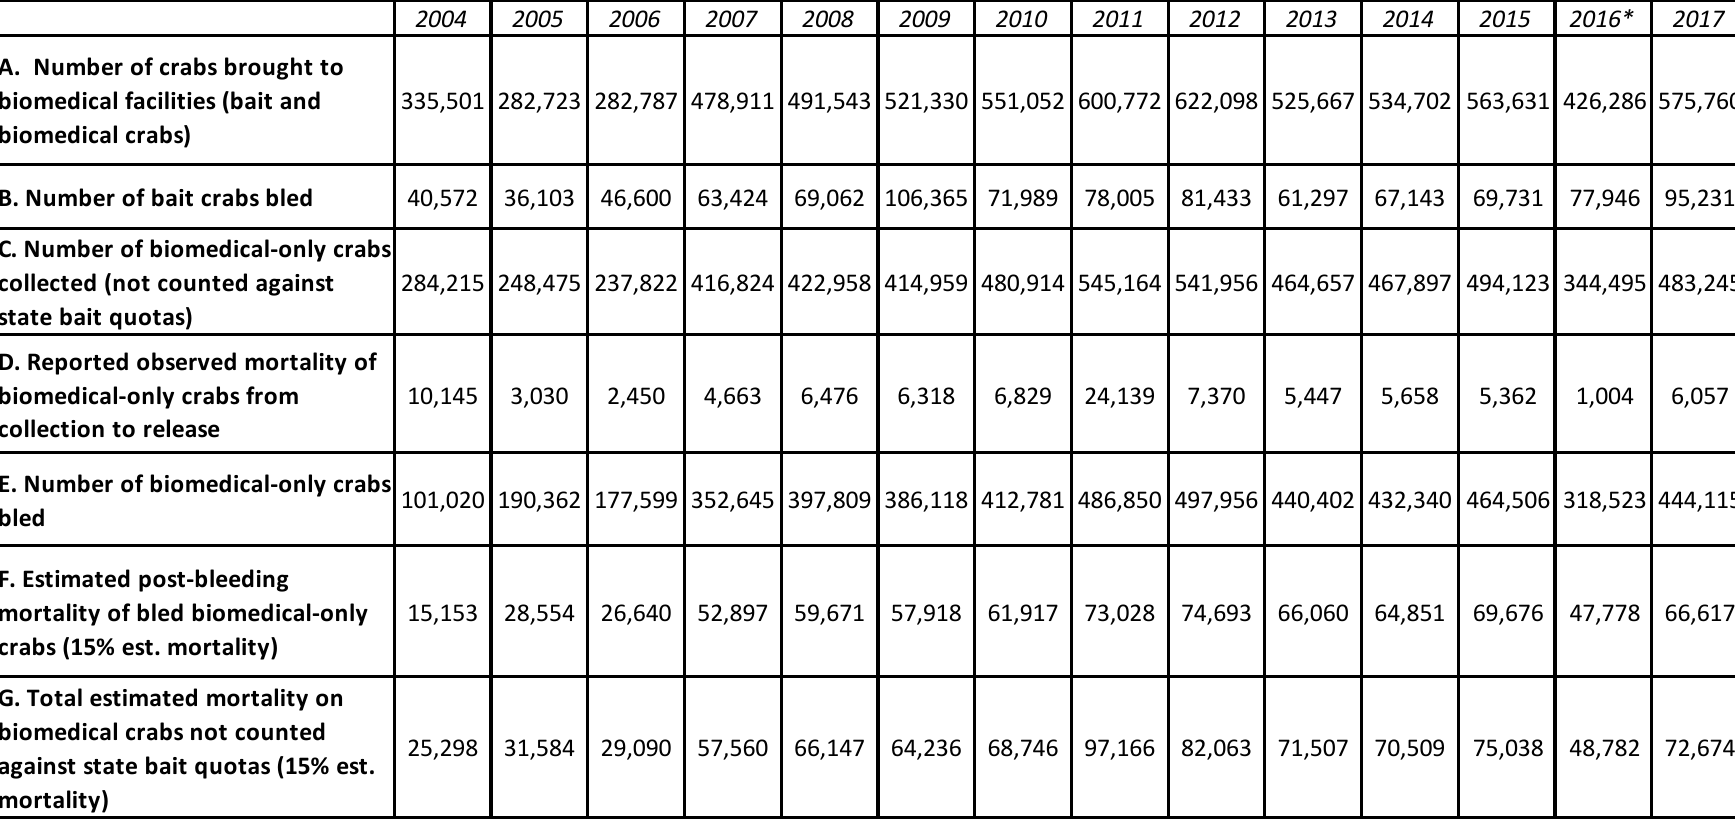
Table 15. Numbers of horseshoe crabs collected, bled, and estimated mortality for the biomedical industry as reported in annual FMP